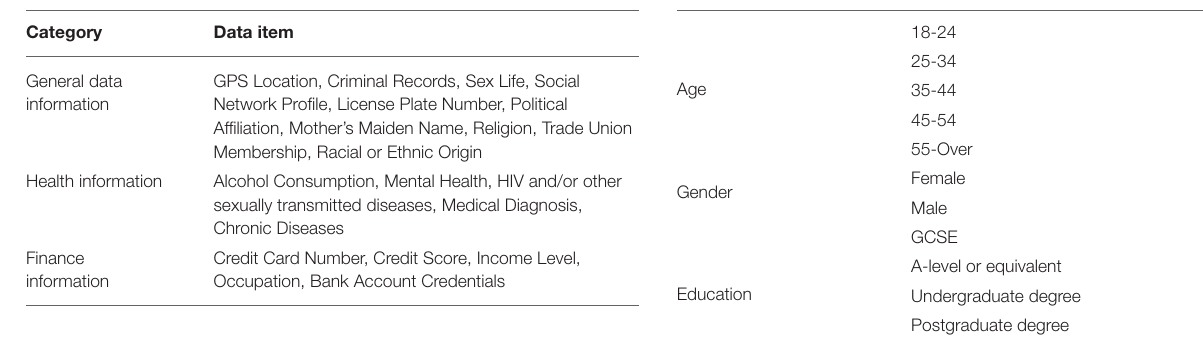
TABLE 4 | Demographic profile of